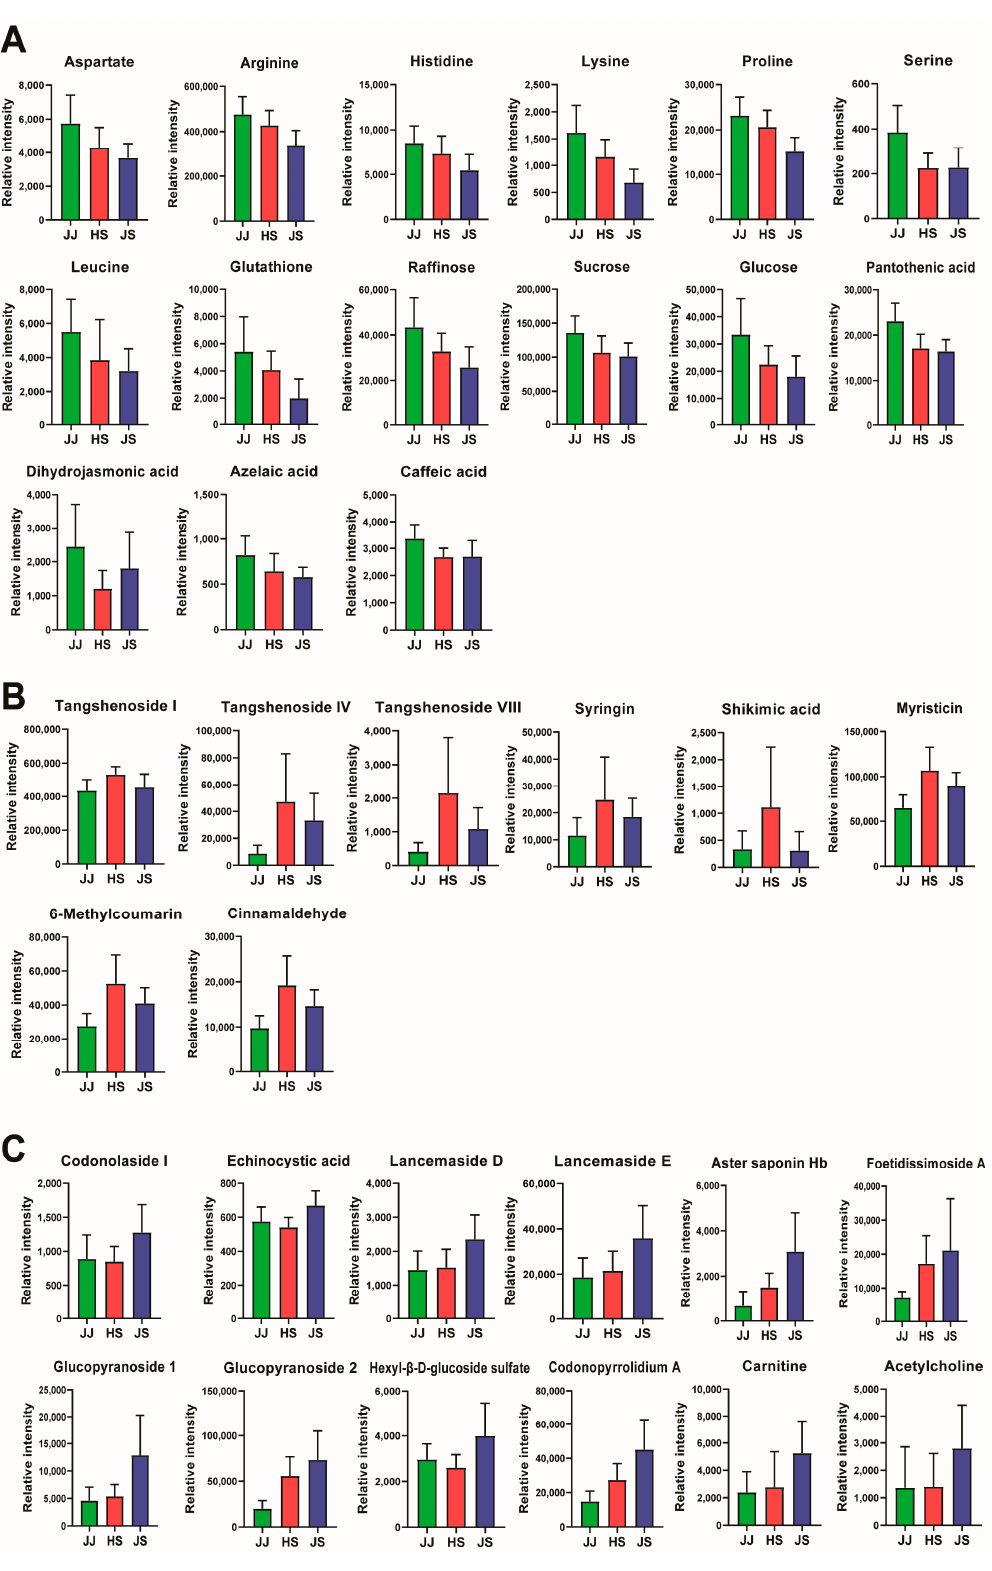
Figure 3. Bar graphs of the normalized peak intensity of significantly different metabolites belonging to group 1 ( A ), group 2 ( B ), and group 3 ( C ) of Figure 2 in C. lanceolata samples obtained from three different geographical origins. The results are expressed as mean ± SD. Glucopyranoside 1 is hexyl- β -D-glucopyranosyl-(1 → 2)- β -D-glucopyranoside and glucopyranoside 2 is (E)-2-hexenyl- α -L-arabinopyranosyl-(1 → 2)- β -D-glucopyranoside.